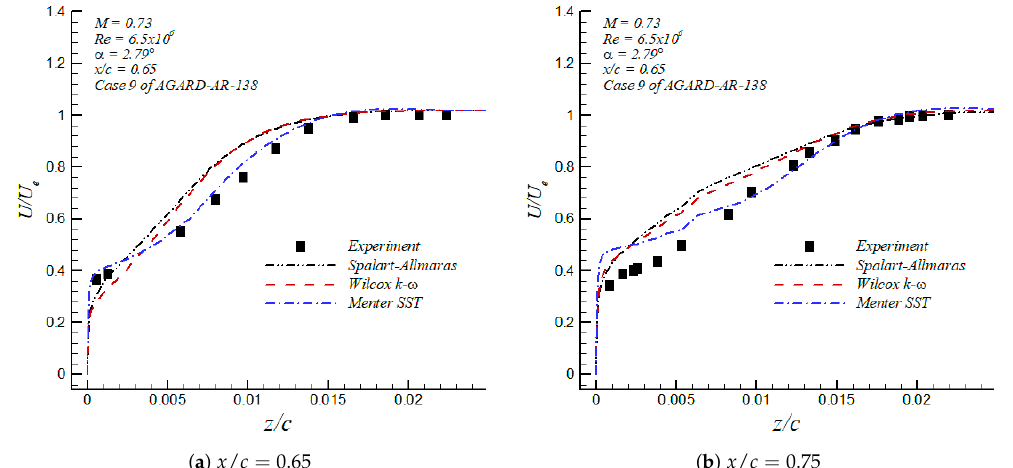
Figure 7. Mean streamwise velocity distribution in the RAE2822